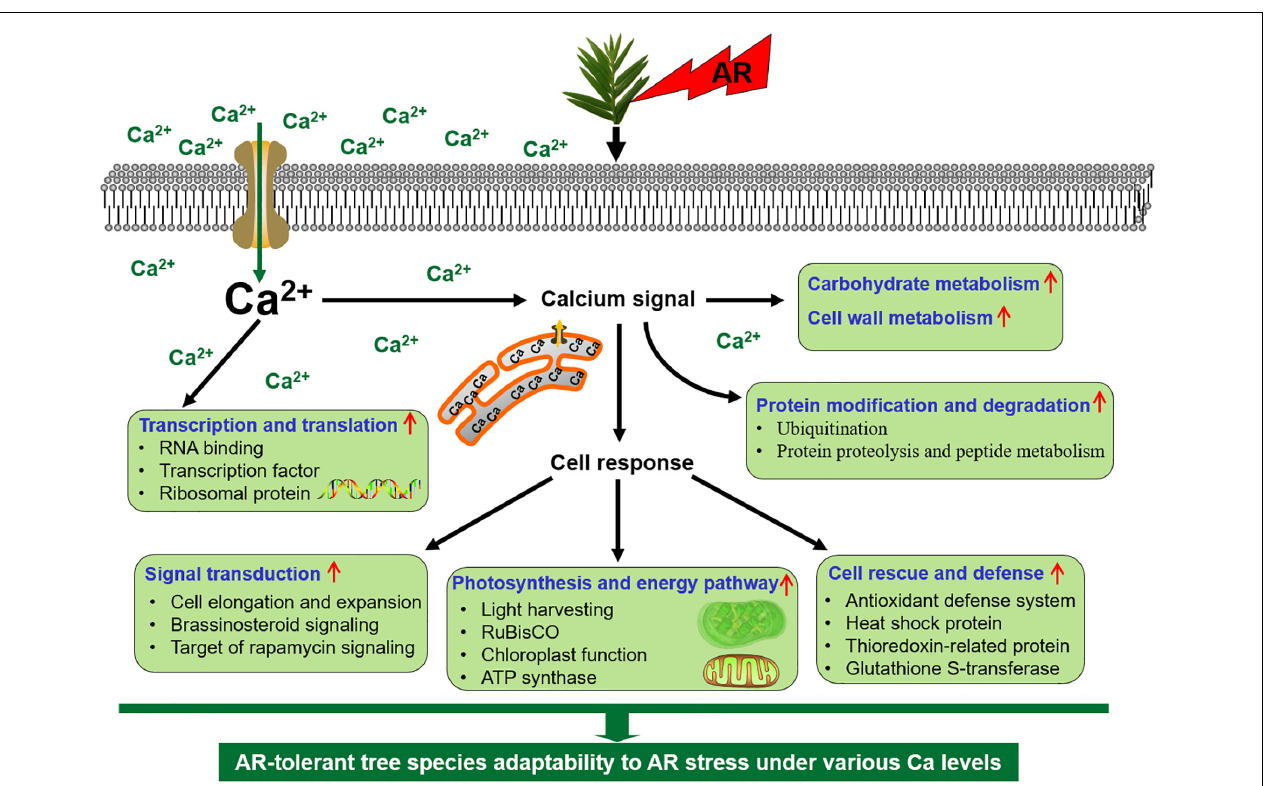
FIGURE 8 | An adaptive strategy of T. wallichiana var. mairei leaves response to AR stress under different Ca